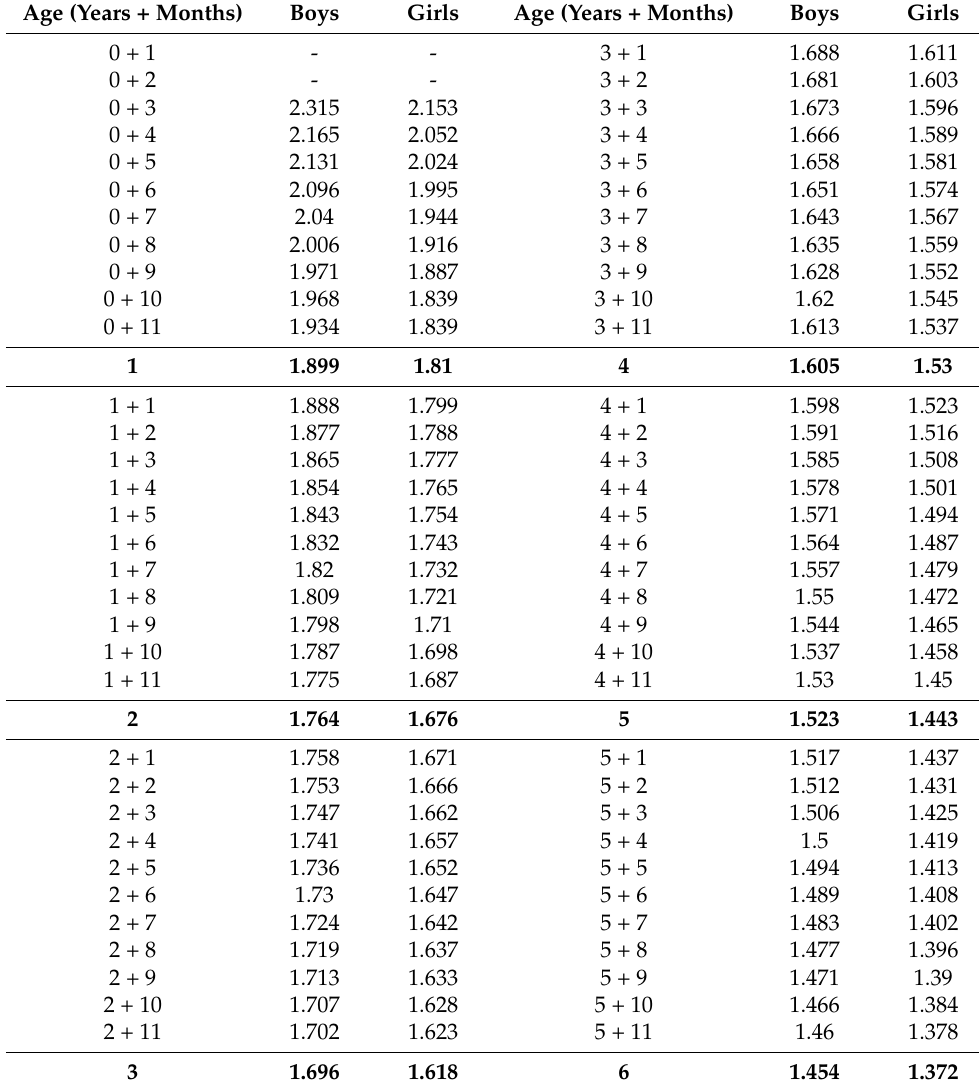
Figure 4. Equation for spinal sitting height multiplier. M, age-specific multiplier; S, age-specific sitting height. Table 1. Sitting height multiplier for 0 to 3 years of age.